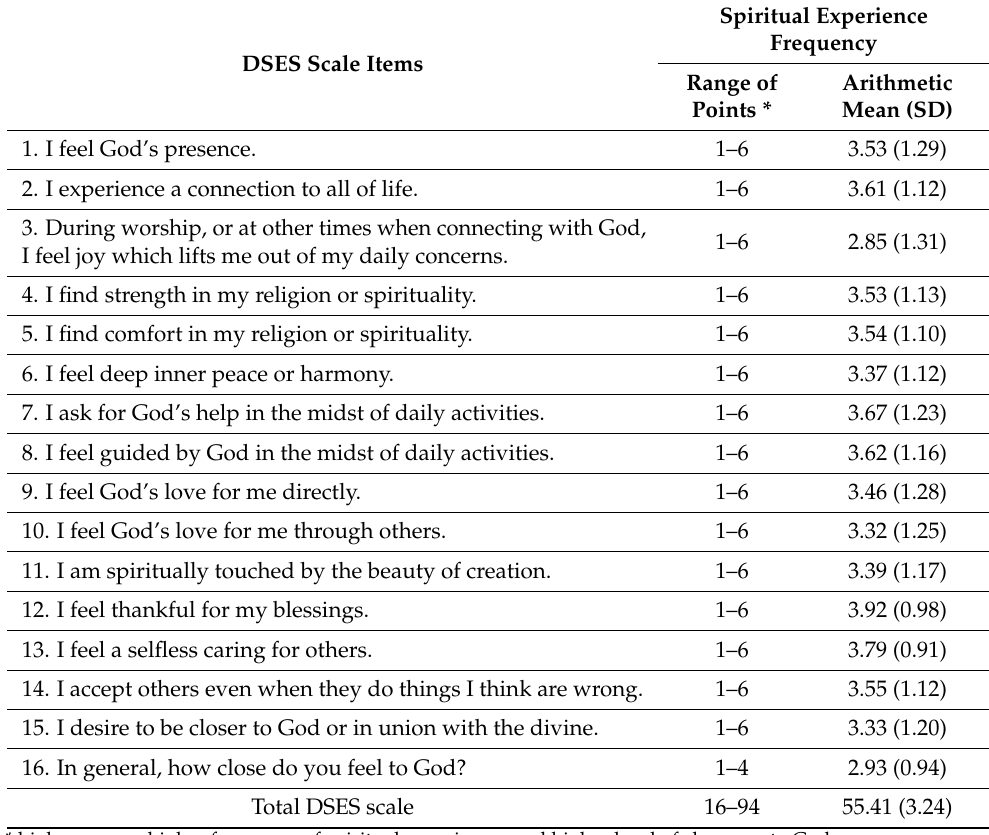
Table 3. Nurses’ daily spiritual experiences when providing EoLC (n =